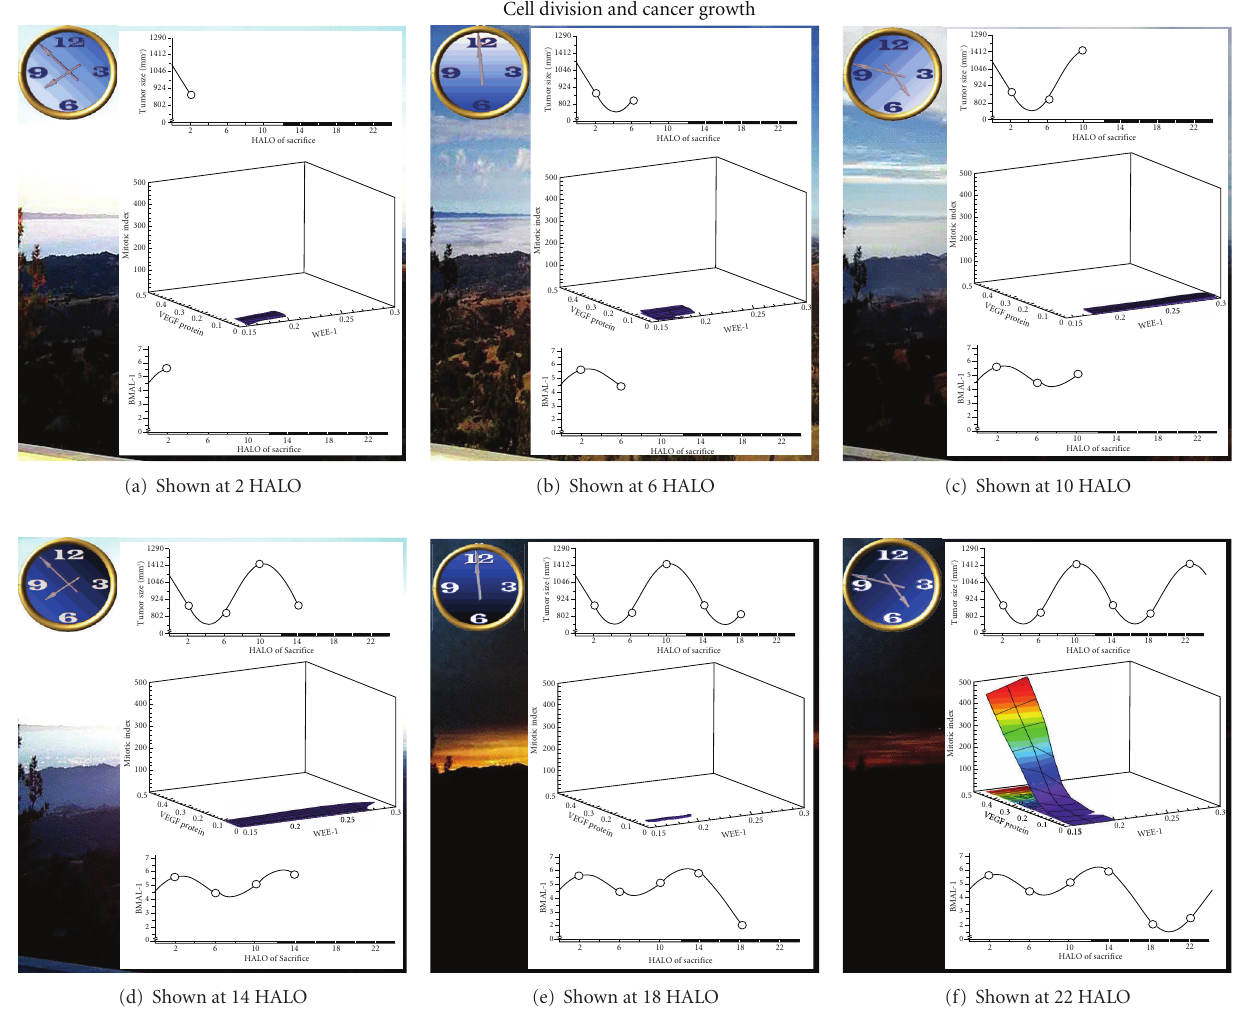
Figure 2: Snapshot of Supplementary Movie 2. WEE-1 is known to prevent or gate mitosis at the G 2 M interface of the cell cycle. VEGF is known to promote cancer growth and cancer cell division. Throughout the day as WEE-1 increases, no mitosis occurs. As WEE-1 decreases, mitosis appears and gradually increases to a high level. Concurrently, VEGF content of the same tumor cell increases